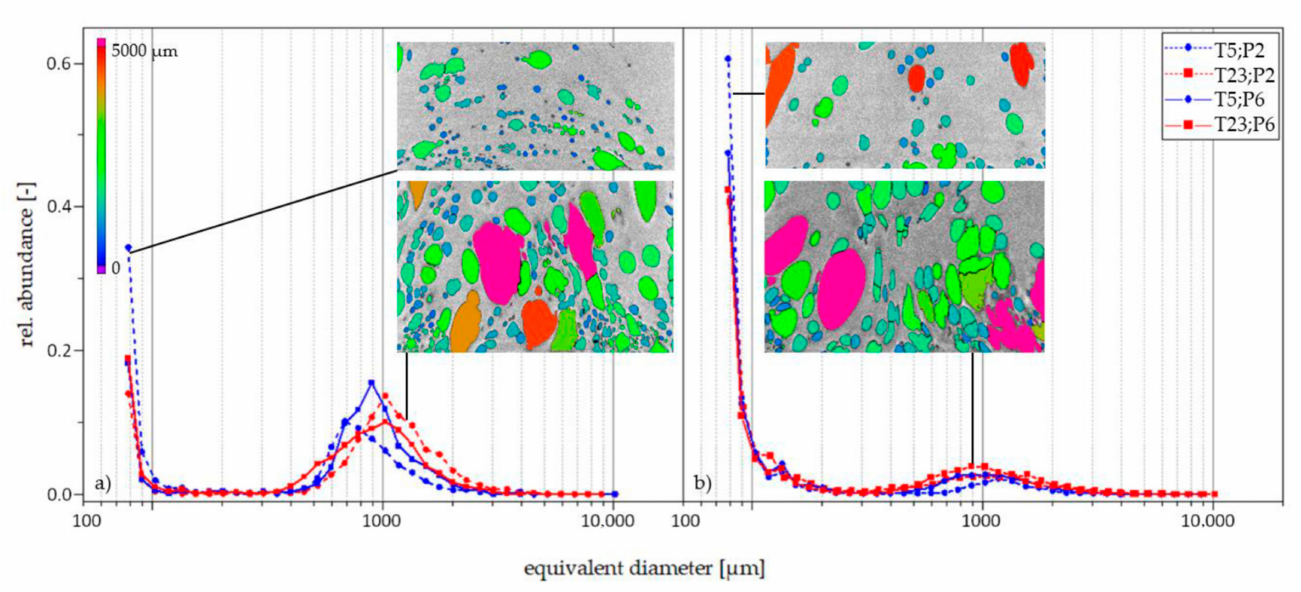
Figure 7. Relative abundance of the equivalent diameter (( a )—W34; ( b )—W48) for degassed sam- ples (A3).